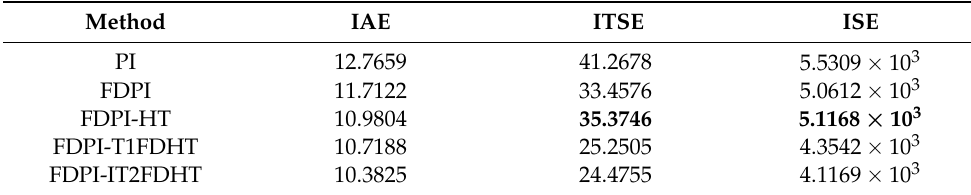
Figure 14. Motor speed tracking results under load situation. Table 9. Evaluation indicator results under load